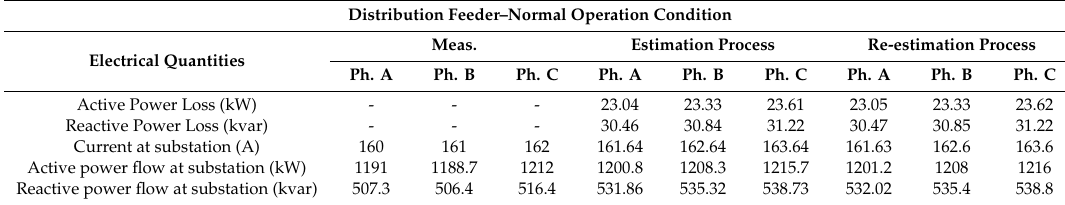
Table 2. Result for estimated system losses and comparison between measured, estimated and re-estimated data at